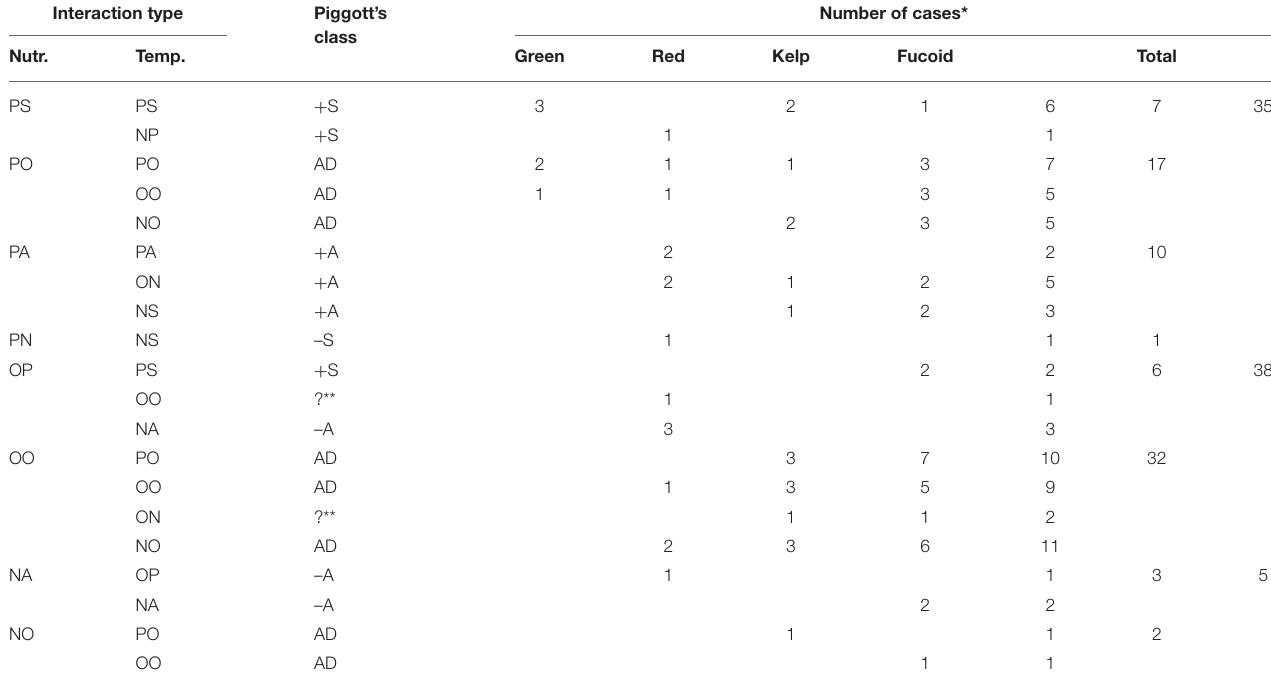
Number of cases*